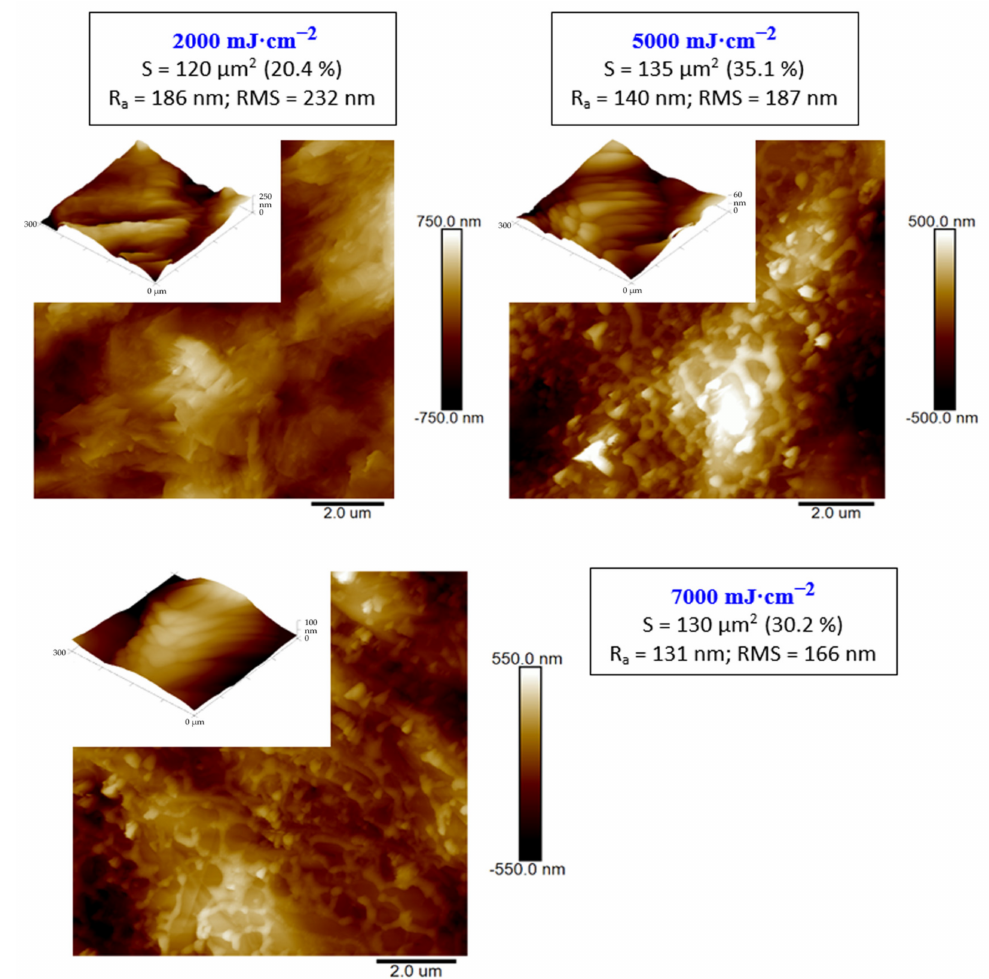
Figure 3. Atomic force microscopy images of carbon sheet exposed with high energy excimer laser and laser fluencies from 2000 to 7000 mJ · cm − 2 . The scanning areas were 10 × 10 µ m 2 . R a represents the average surface roughness, RMS root mean square roughness, integral area (S), and the difference from the basic area. The inset represents the 300 × 300 nm 2 square detail of the